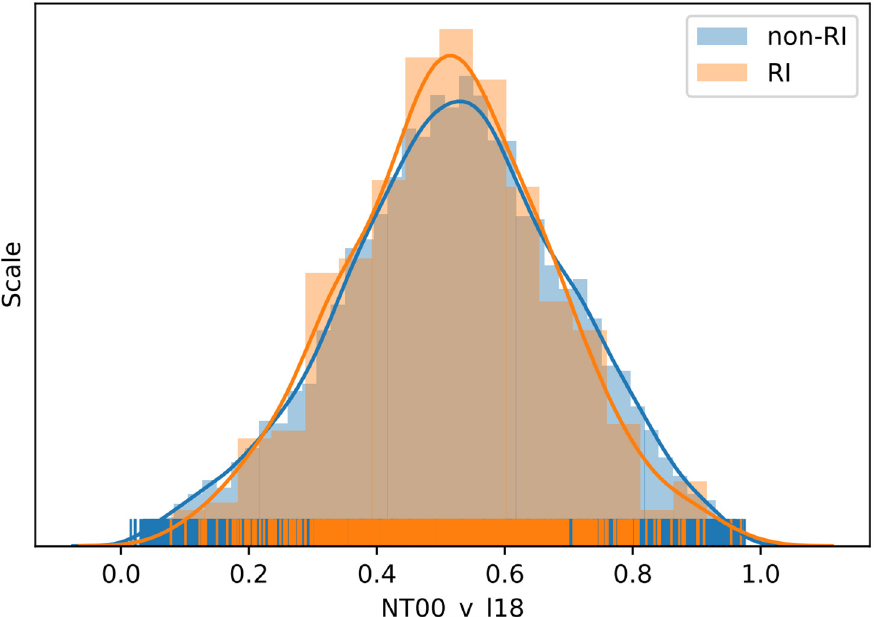
Table 8. Basic statistic values for features NT00_v_l18, NT18_pv_l1, NT18_u_l1, and NT00_w_l18 for RI and non ‐ RI (NRI) instances, respectively. The p ‐ values are for the Mann–Whitney test against the same median in each case.